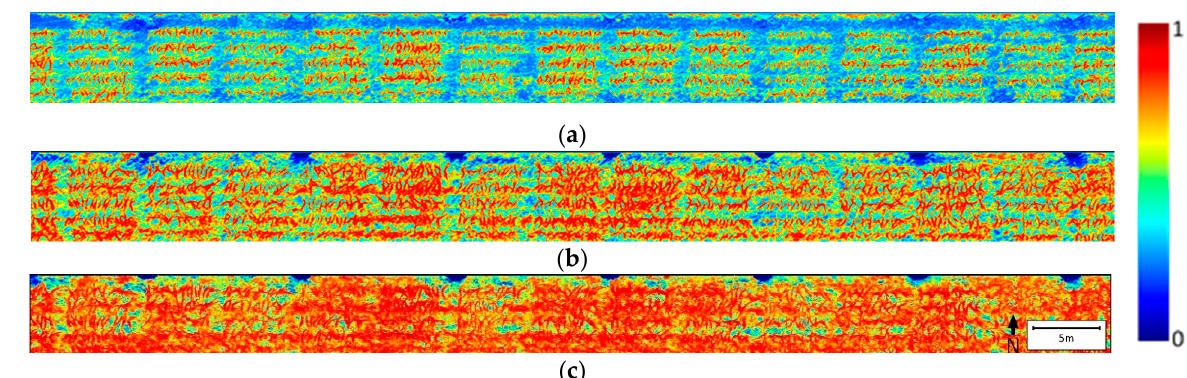
Figure 2. The NDVI heatmaps for the whole field at three leaf stages with different accumulated after days planting (DAP). ( a ). 31 DAP, leaf stage V4; ( b ). 38 DAP, leaf stage V6; ( c ). 49 DAP, leaf stage V9.